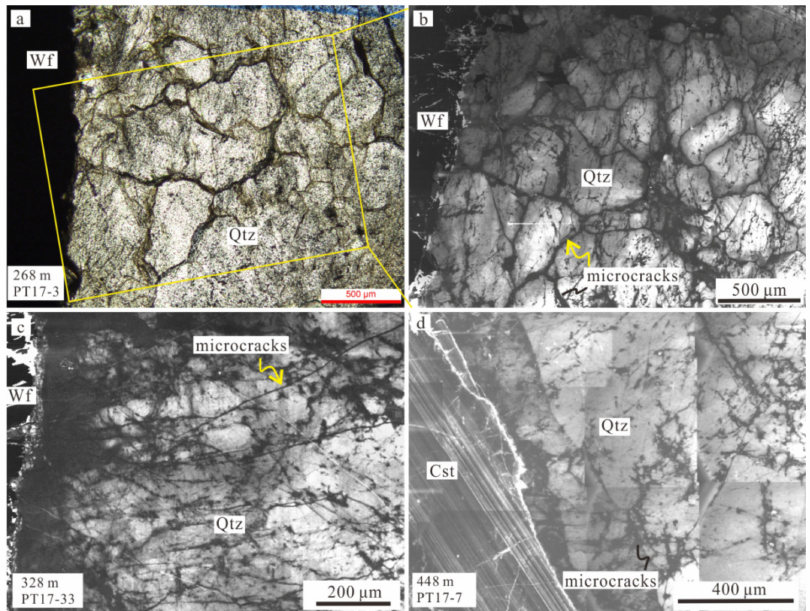
Figure 8. Plane-polarized and SEM–CL panchromatic images of the quartz adjacent to wolframite and cassiterite at different levels. ( a , b ) are the same quartz under plane-polarized and SEM–CL, respectively. ( c , d ) show SEM–CL images of the quartz adjacent to wolframite and cassiterite, respec- tively. The SEM–CL images of quartz are bright except many dark microcracks. Wf, wolframite; Cst, cassiterite; and Qtz, quartz.